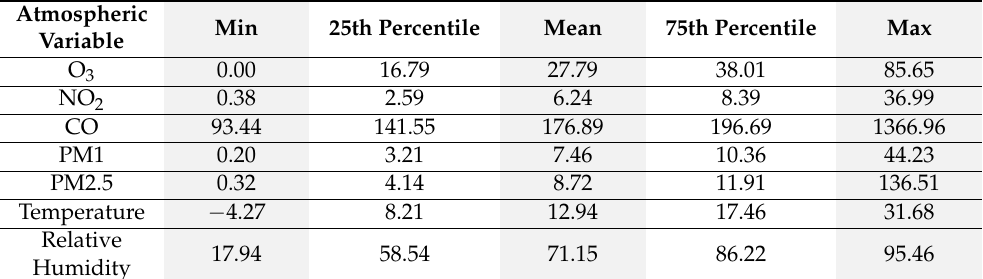
Table 3. Statistics based on the hourly (15 min) means of the different atmospheric variables measured by the AEMS between the 27 February 2021 and 24 October 2021. For O 3 , NO 2 and CO hourly gas [ppb] and for PM 15 min concentration means [ µ g/m 3 ] were used. The temperature [ ◦ C] and relative humidity [%] statistics are based on hourly